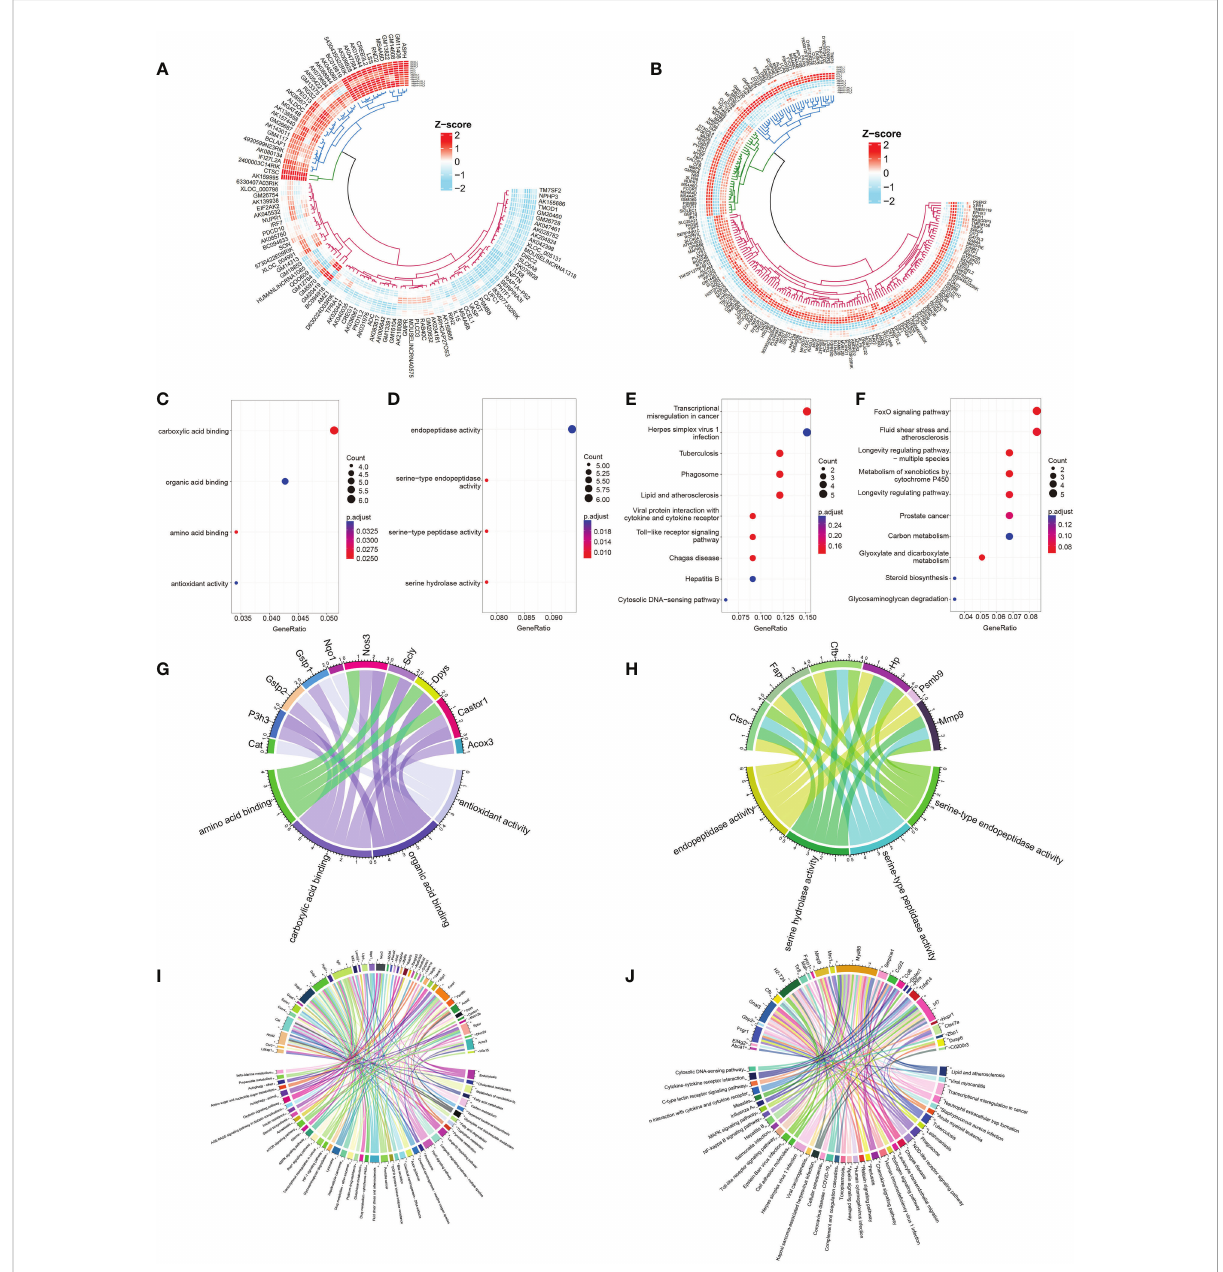
FIGURE 3 Identi fi cation and selection of 190 DEmRNAs/110 DElncRNAs and enrichment analysis of the two groups of DEmRNAs. (A, B) Circular heatmaps show the common differentially expressed genes among the three groups (LPS vs. DMSO, AdipoAI vs. DMSO and AdipoAI+LPS vs. LPS). (A) DElncRNAs. (B) DEmRNAs. (C) Molecular function enrichment analysis of 122 DEmRNAs (DMSO vs. LPS ↓ , DMSO vs. AdipoAI ↑ and LPS vs. LPS +AdipoAI ↑ ). (D) KEGG for 122 DEmRNAs. (E) Molecular function enrichment analysis of 68 DEmRNAs (DMSO vs. LPS ↑ , DMSO vs. AdipoAI ↓ and LPS vs. LPS+AdipoAI ↓ ). (F) : KEGG for 68 DEmRNAs. (G – J) Bubble diagrams showing mRNAs involved in molecular function enrichment analysis and KEGG. (G) 122 DEmRNAs in molecular function enrichment analysis. (H) 122 DEmRNAs in KEGG. (I) 68 DEmRNAs in molecular function enrichment analysis. (J) 68 DEmRNAs in